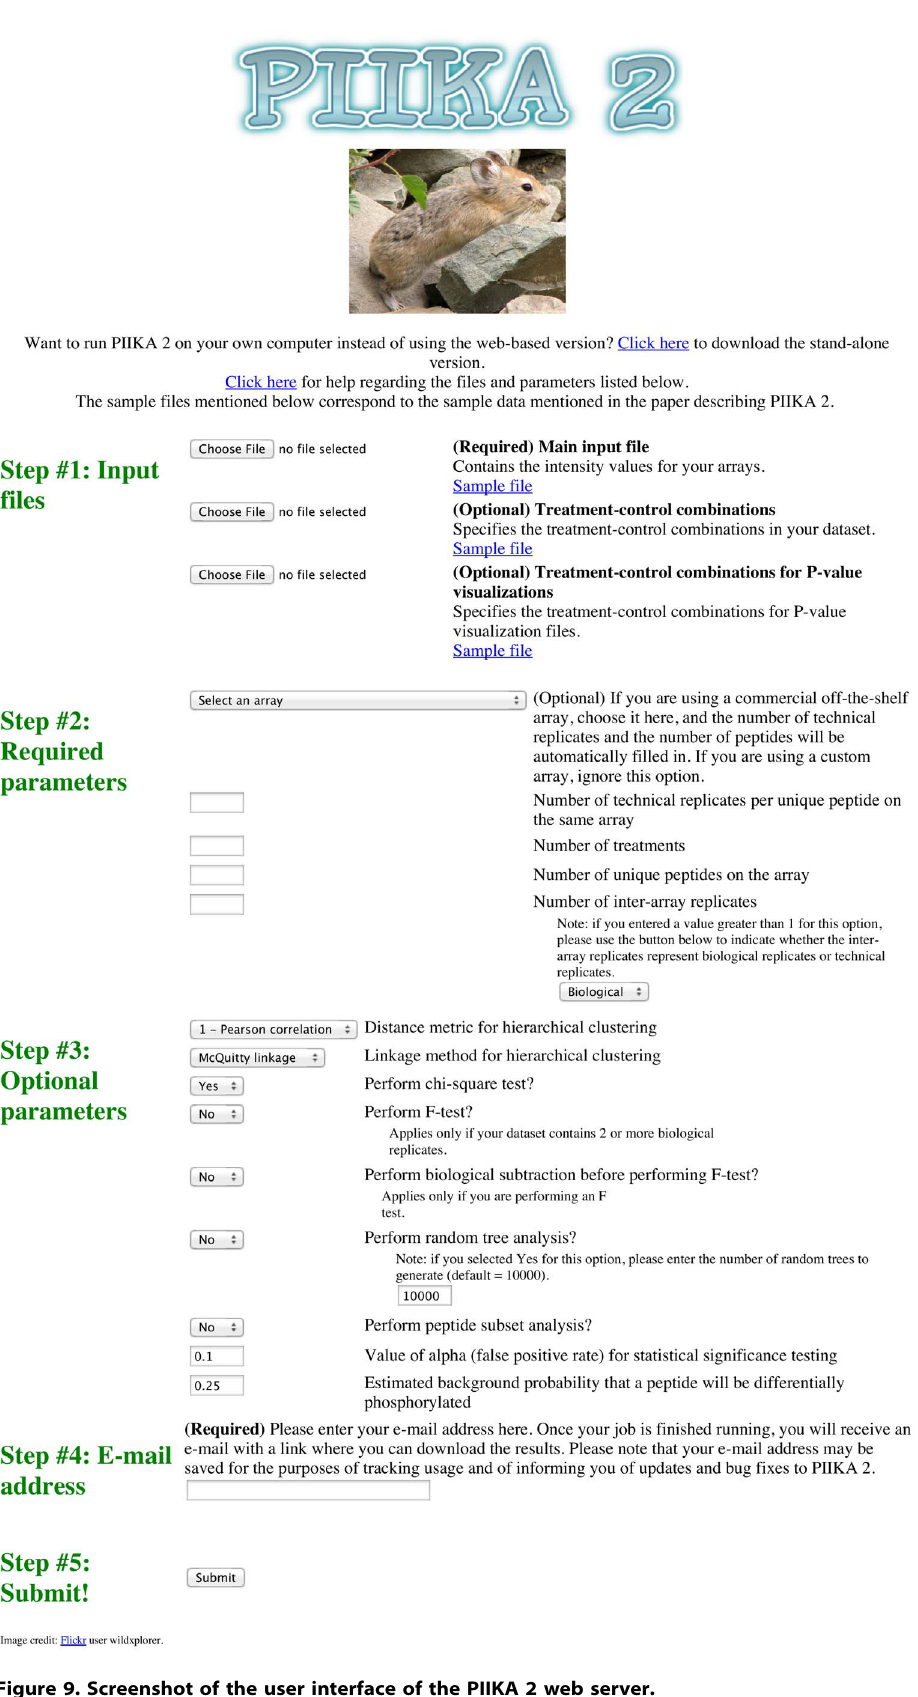
Figure 9. Screenshot of the user interface of the PIIKA 2 web server. doi:10.1371/journal.pone.0080837.g009 PLOS ONE |